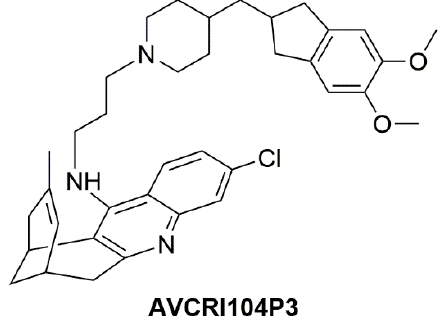
Figure 8. Chemical structure of AVCRI104P3.